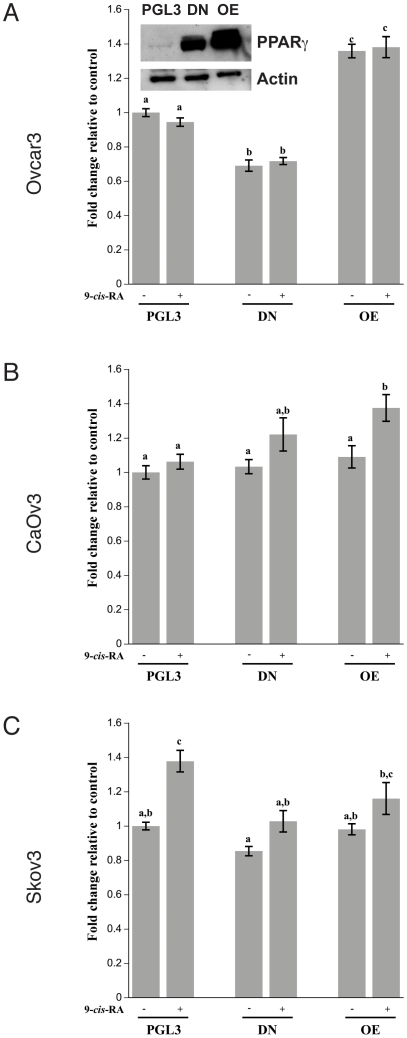
Effect of 9-cis-Retinoic Acid (9-Cis-RA) treatment on Ovcar3, CaOv3 and Skov3 PPRE luciferase activity.Cells were double transfected with a PPRE construct and one of the following: Empty vector (PGL3), DN form of PPARγ (DN) or wildtype form of PPARγ (OE). After the double transfections, cells were treated for 24 hours with vehicle control (DMSO) or 1 µM of 9-Cis-RA in the dark. PPRE luciferase activity is illustrated for (A) Ovcar3, (B) CaOv3, and (C) Skov3. Controls represent cells that were transfected with the empty vector and treated with vehicle control, shown as the first bar in each panel. Results for the PPRE luciferase assay are the means ± SEM for at least 9 measurements. Bars that do not share a letter designation are significantly different (p<0.05). Insert Panel A: Western blot of PPARγ protein in Ovcar3 cells double transfected with a PPRE construct and either empty vector, DN or OE PPARγ constructs and treated with vehicle control for 24 hours.